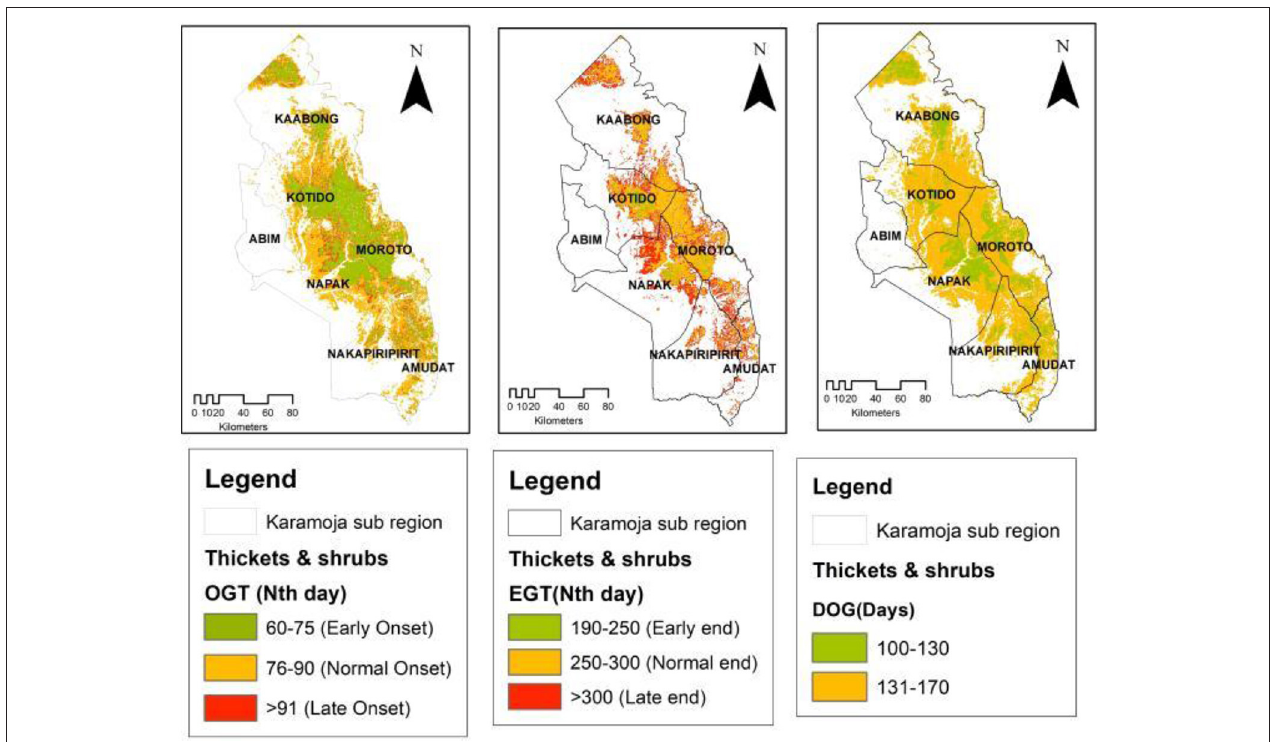
FIGURE 7 | Thicket and shrub OGT, EGT, and DOG spatial